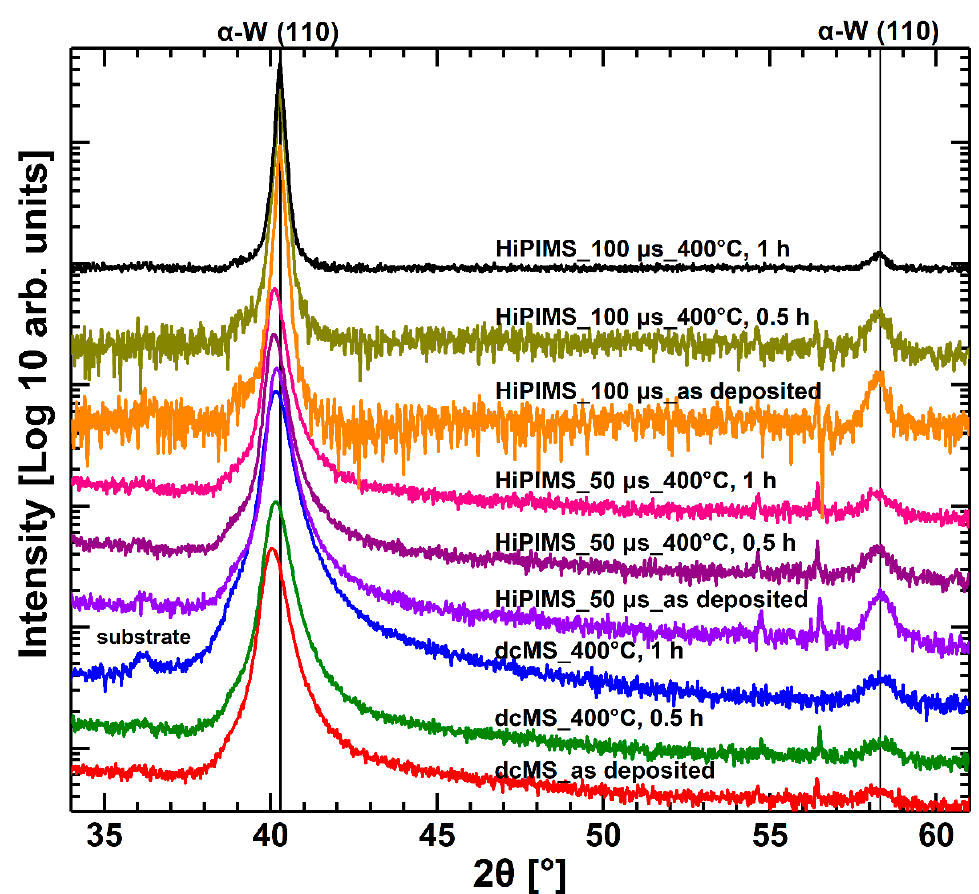
Figure 11. XRD spectra of W thin films after vacuum annealing at 400 °C for 0.5 and 1 h.